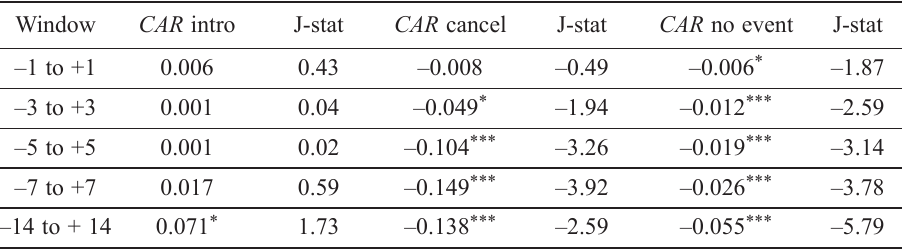
Table 3. Averaged CAR statistics for trademark introduction and cancellation